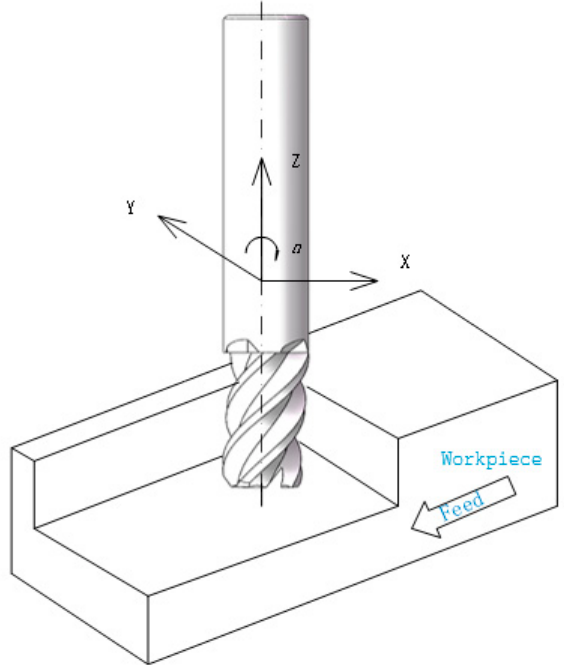
Figure 6. Milling